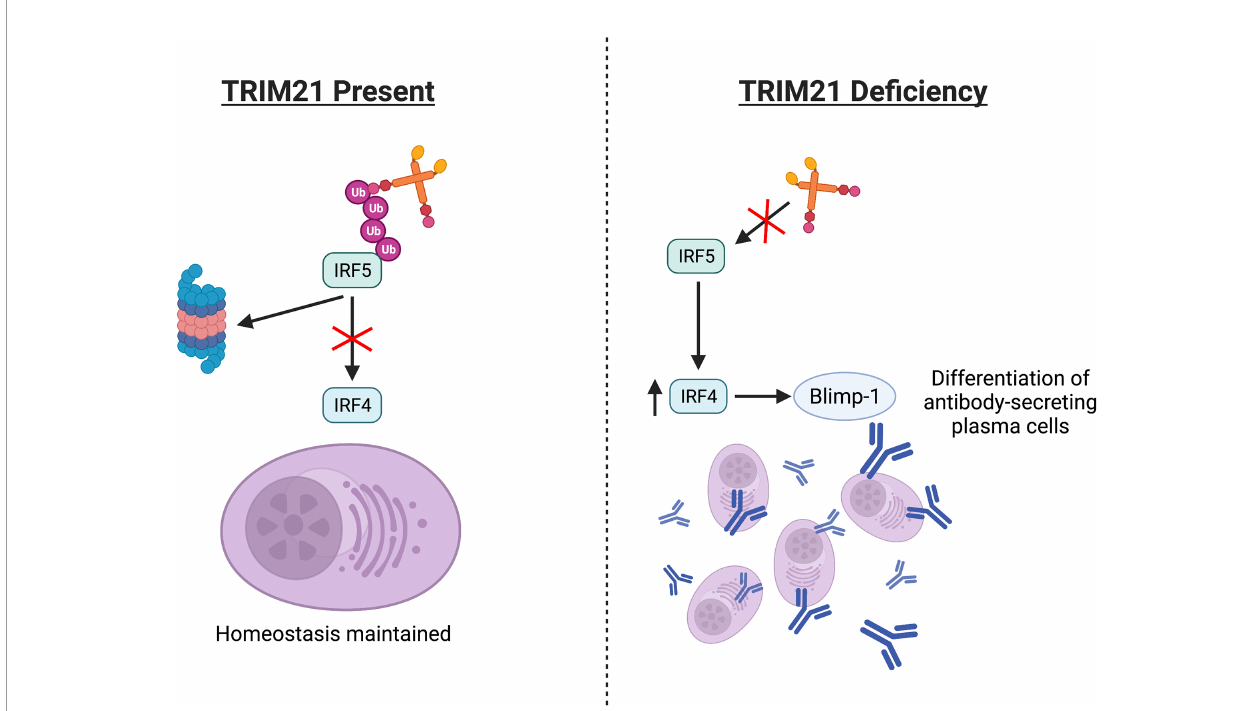
FIGURE 4 | Absence or de fi ciencies in TRIM21 may alter the IRF4/5 axis. TRIM21 regulates IRF5 via ubiquitination, potentially affecting downstream IRF4 and Blimp-1 expression. Aberrant regulation may increase differentiation of antibody-secreting plasma